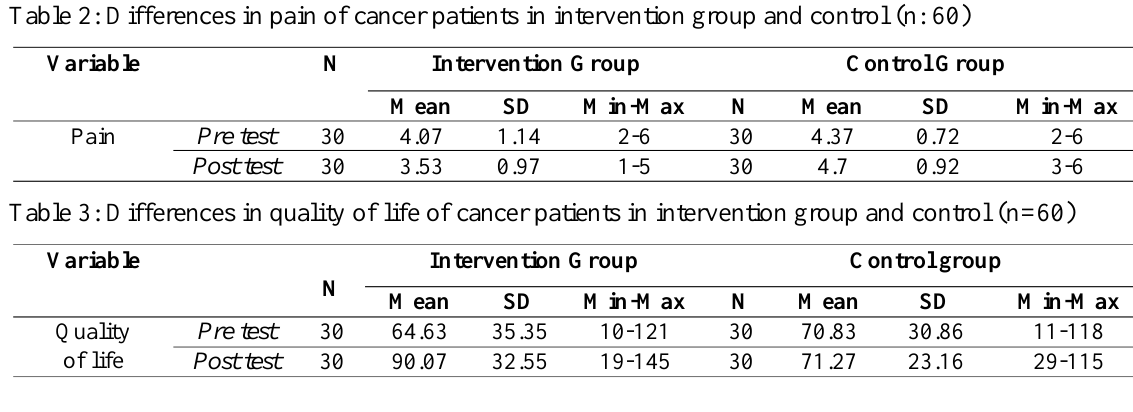
and their wives but their parents and children.